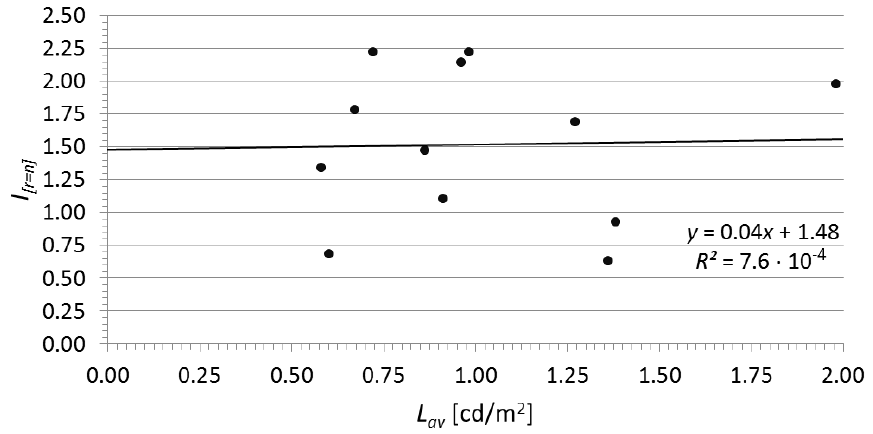
Figure 12. Scenario 1 (present status): correlation between I and L av .